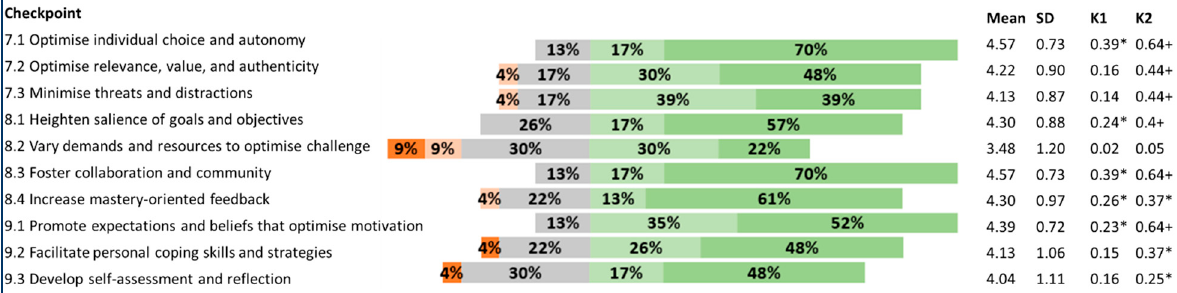
Figure 3. “Provide multiple means of engagement” evaluation results. Note: standard deviation (SD), Kappa for 5 values (K1); Kappa for 3 values (K2); fair agreement *; moderate, substantial, and perfect agreements +.